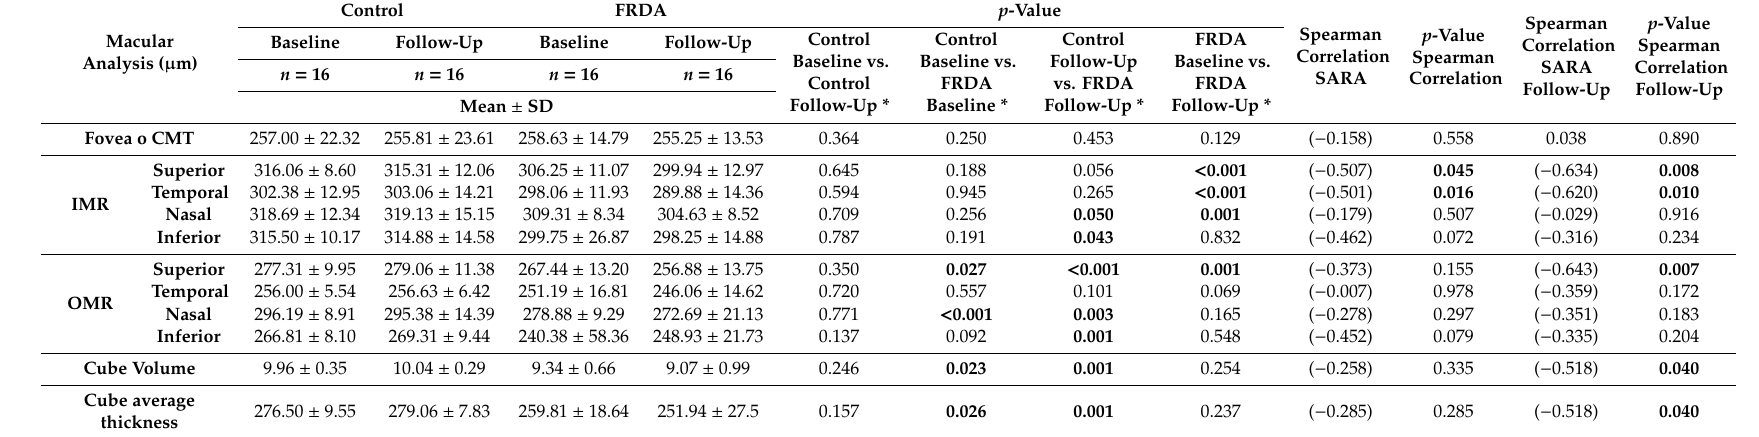
Table 4. Analysis of macular thickness measures by OCT between FRDA and control